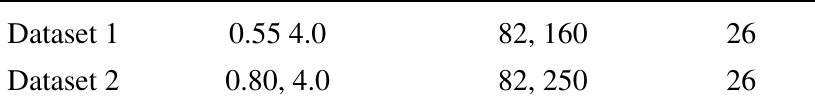
Table 8. Acquisition parameters in the case of two tissues; the datasets are composed of four images.